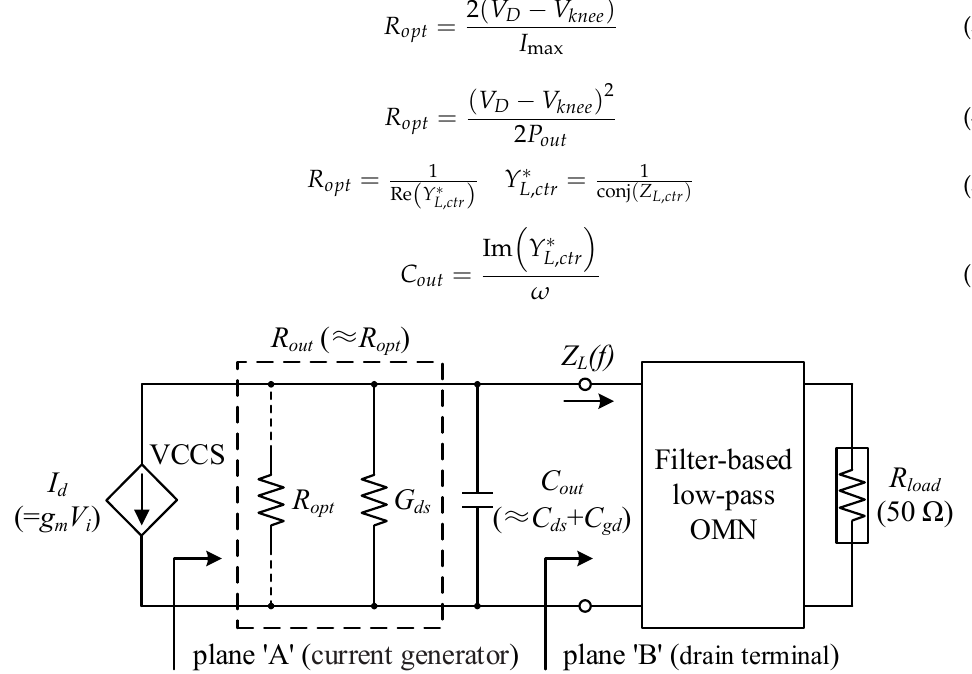
Figure 4. Equivalent parallel RC model for the large-signal output impedance of an HEMT.